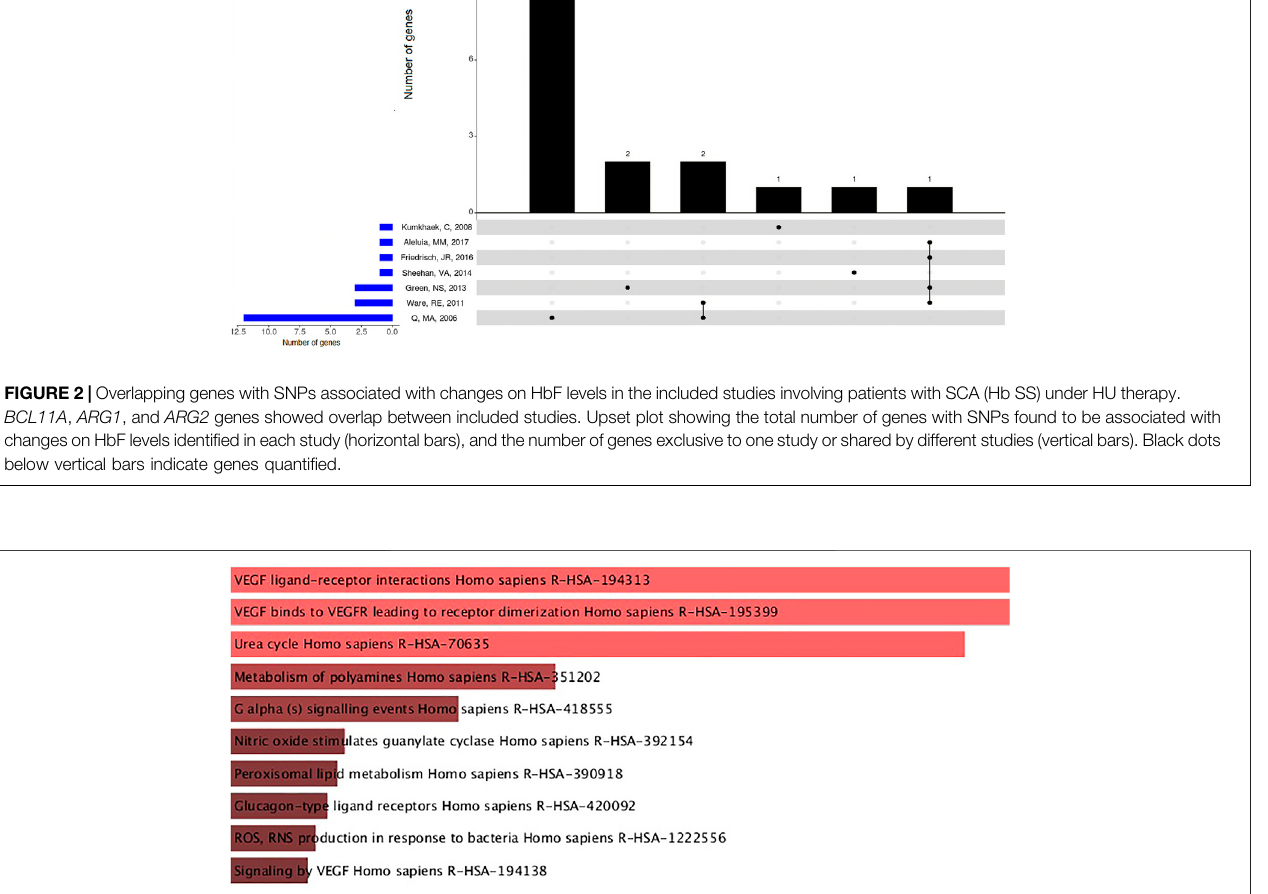
FIGURE 3 | Reactome pathways obtained from enrichment analysis of the set of genes with SNPs found to be associated with HbF changes in patients with SCA treated with hydroxyurea. Pathways are ordered from top to bottom according to the lowest adjusted p -values, and light red bars indicate adjusted p -values < 0.001.